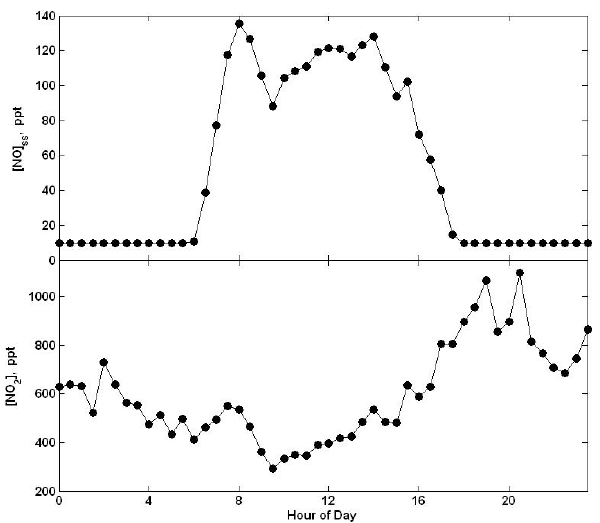
Fig. 8. Mean diurnal patterns of calculated [NO] and observed [NO 2 ]. [NO] ss was estimated assuming NO-NO 2 -HO 2 -RO 2 -O 3 photostationary state with [RO 2 ]=[HO 2 ]. [NO 2 ] was measured with TD-LIF by the UC Berkeley research group.